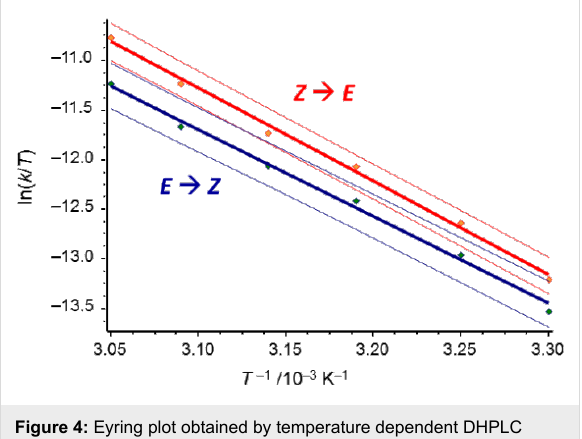
Figure 4: Eyring plot obtained by temperature dependent DHPLC measurements of 4